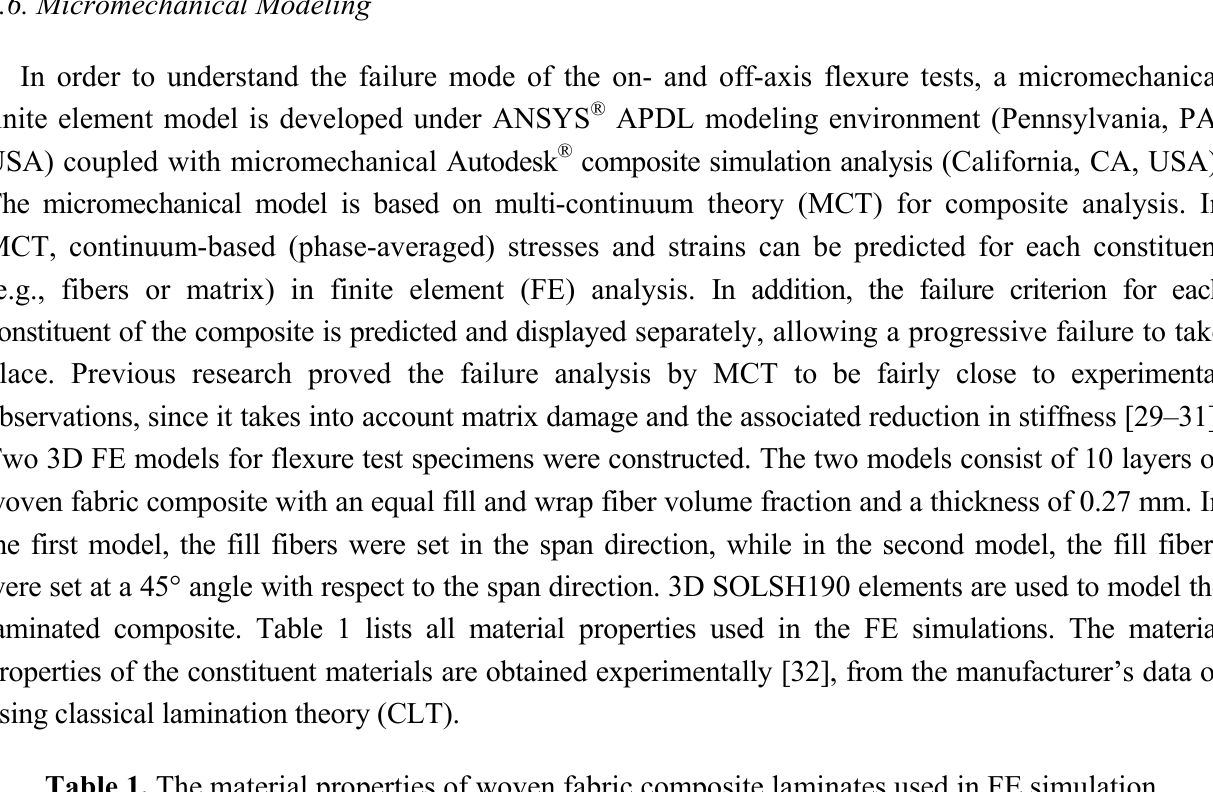
Table 1. The material properties of woven fabric composite laminates used in FE simulation. Designation E